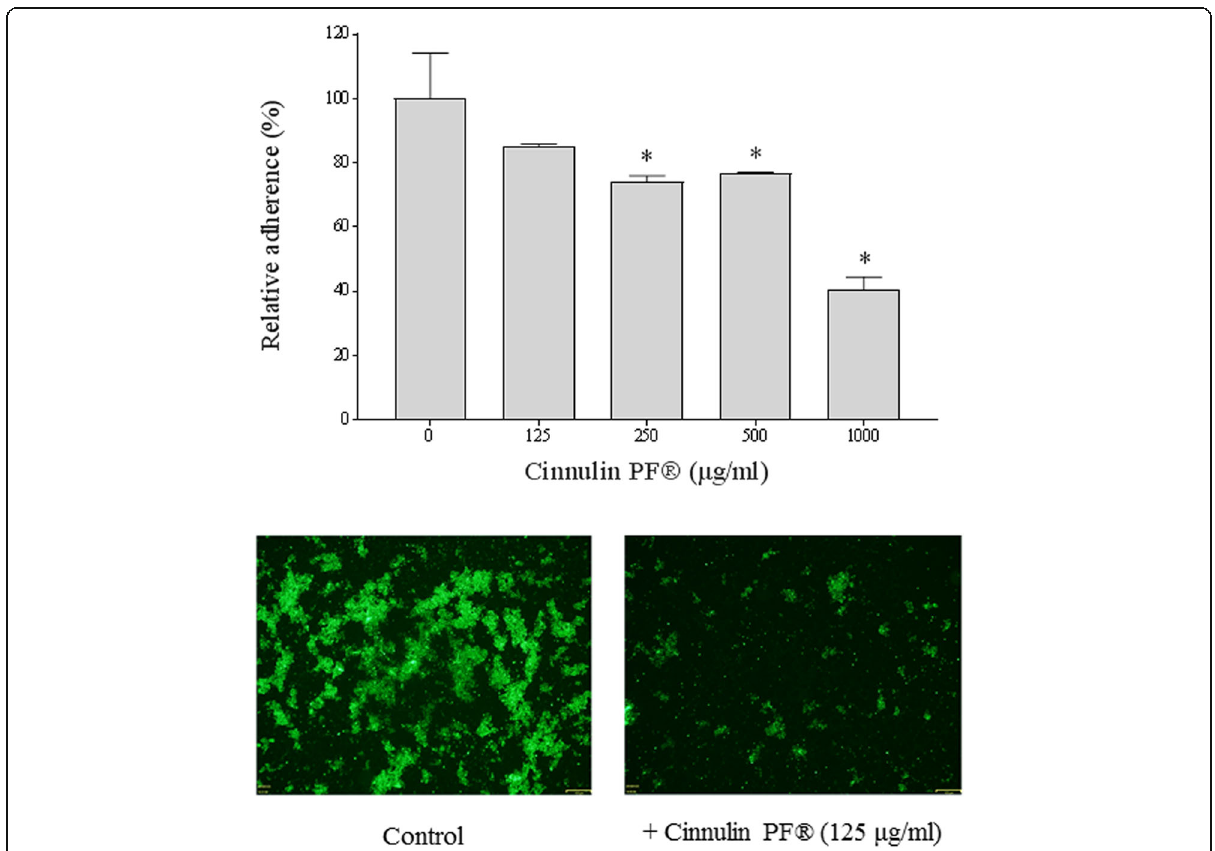
Fig. 5 Effect of Cinnulin PF® on the adherence of C. albicans ATCC 28366 to GMSM-K oral epithelial cells. Panel A: FITC-labeled C. albicans cells adhered to epithelial cells were quantified by measuring fluorescence using a microplate reader. A value of 100% was assigned to C. albicans adhered to epithelial cells in the absence of Cinnulin PF®. Results are expressed as the means± SD of triplicate assays from two independent experiments. *: significantly different from the control ( p < 0.01). Panel B: Fluorescence micrograph of FITC-labeled C. albicans cells adhered to epithelial